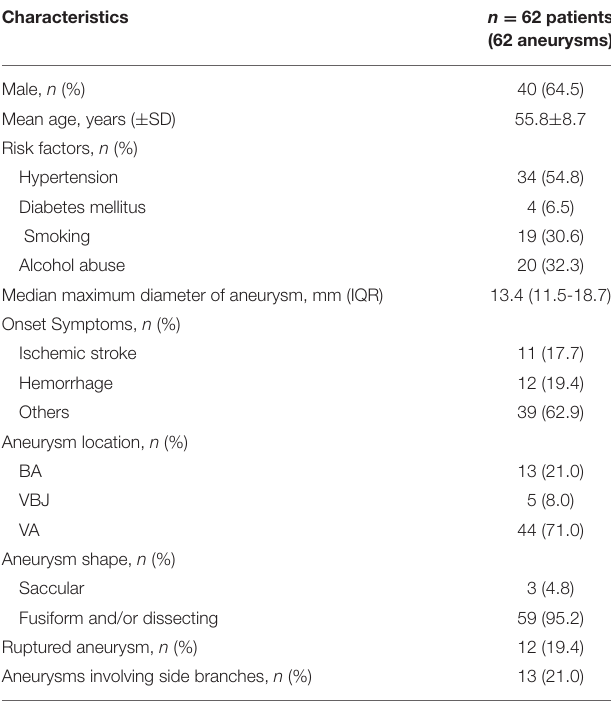
TABLE 1 | Baseline characteristics of patients and